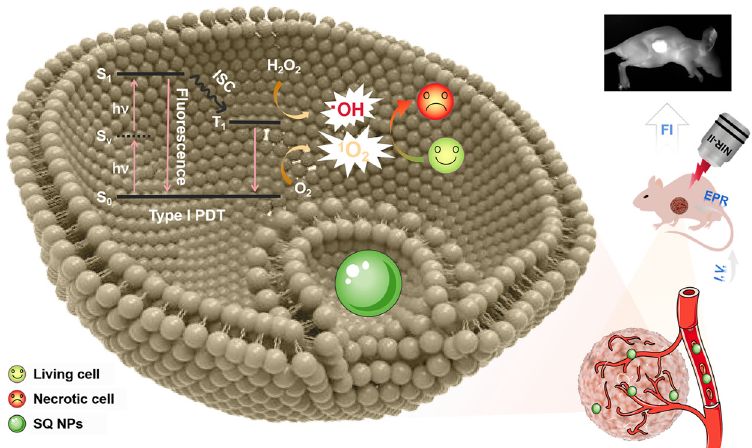
Scheme 1: Schematic illustration of